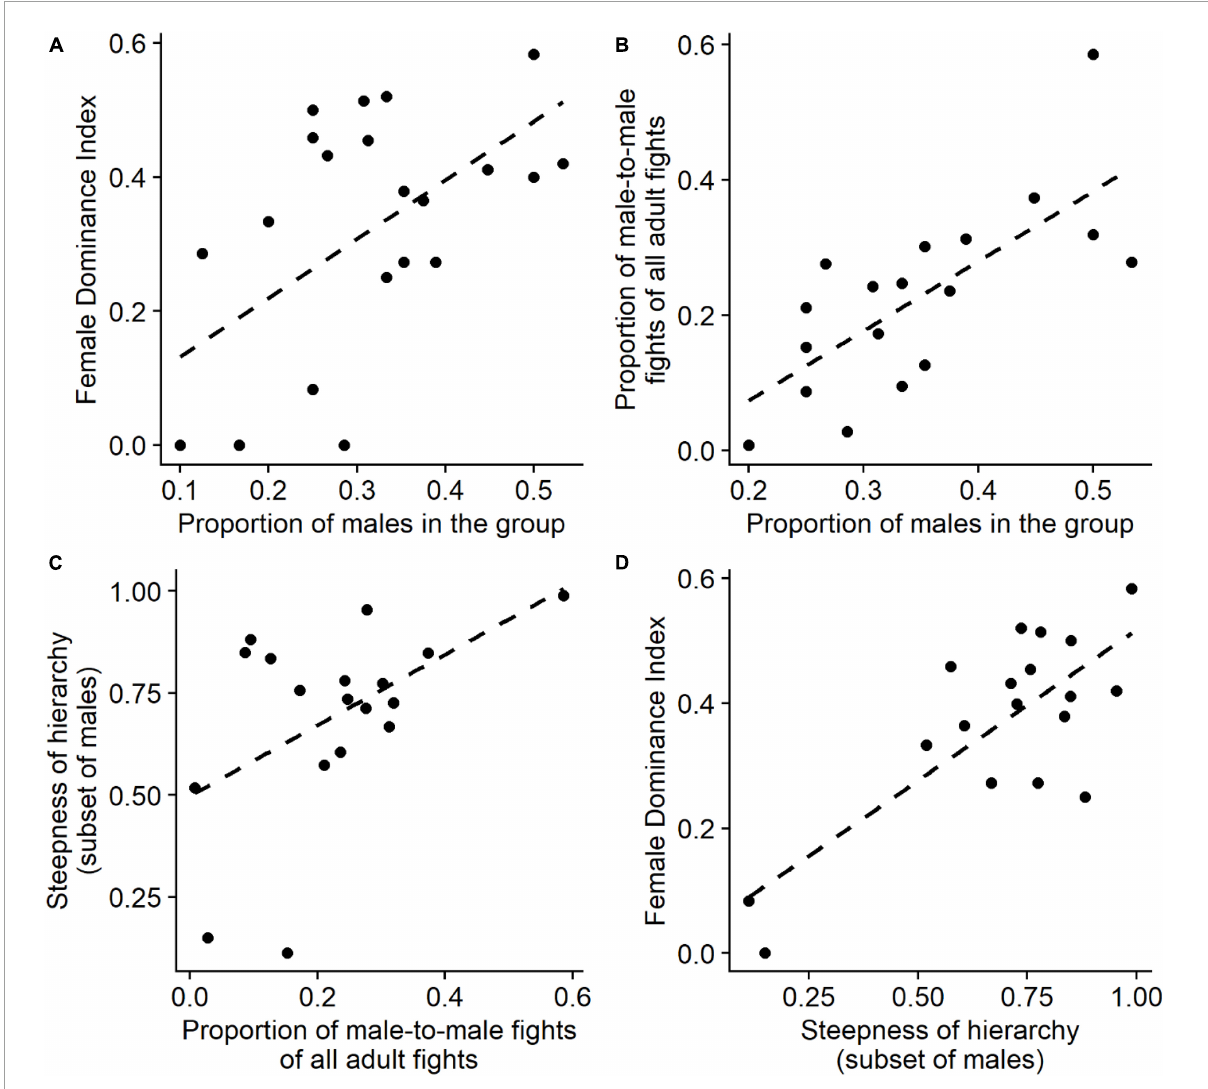
FIGURE1 Summary of relevant relations for the Male Competition Hypothesis: (A) proportion of males in the group versus degree of female dominance (i.e., female dominance index, FDI) (22 group-year points). (B) The proportion of male-to-male fights of all adult fights (relative frequency of male intrasexual competition) versus the proportion of males in the group. (C) The steepness of hierarchy among the subset of adult males versus the proportion of male-to-male fights of all adult fights (i.e., relative frequency of male intrasexual competition). (D) The degree of female dominance (i.e., FDI) versus the steepness of hierarchy among the subset of adult males. Plots (B–D) concern only group-year points with at least two males (18 group-year points). Trend lines (dotted lines) are calculated for (ordinary least squares) linear regressions, using the function “geom_smooth” of the R package “ggplot2” (Wickham, 2016). For more accurate statistical analyses, see